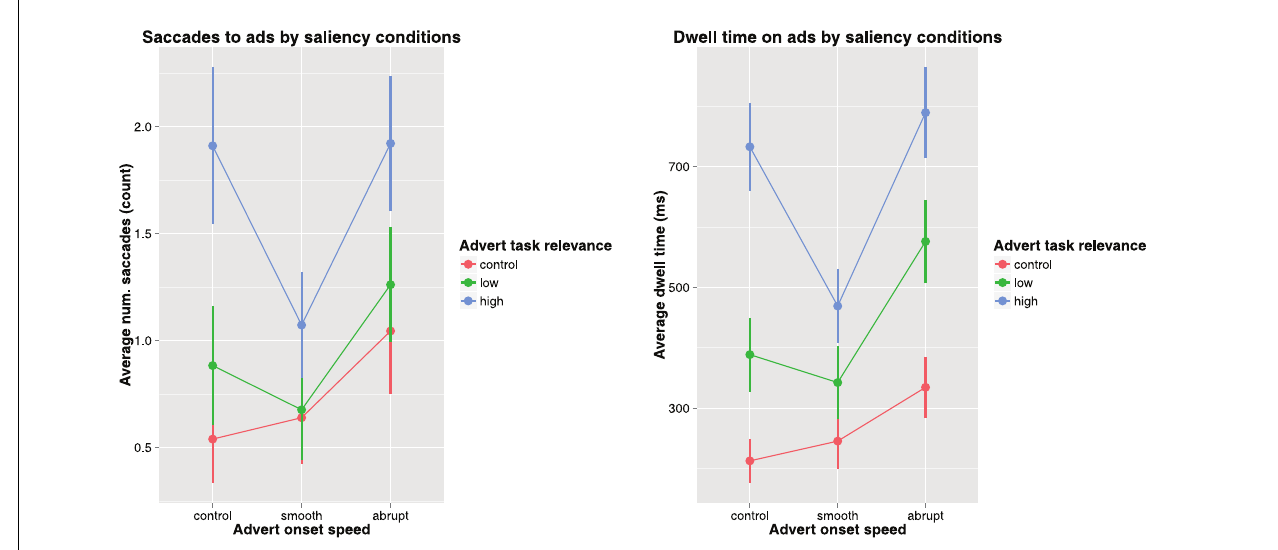
FIGURE 4 | Advert onset speed and task relevance plotted against saccades to ads (left) and dwell time on ads